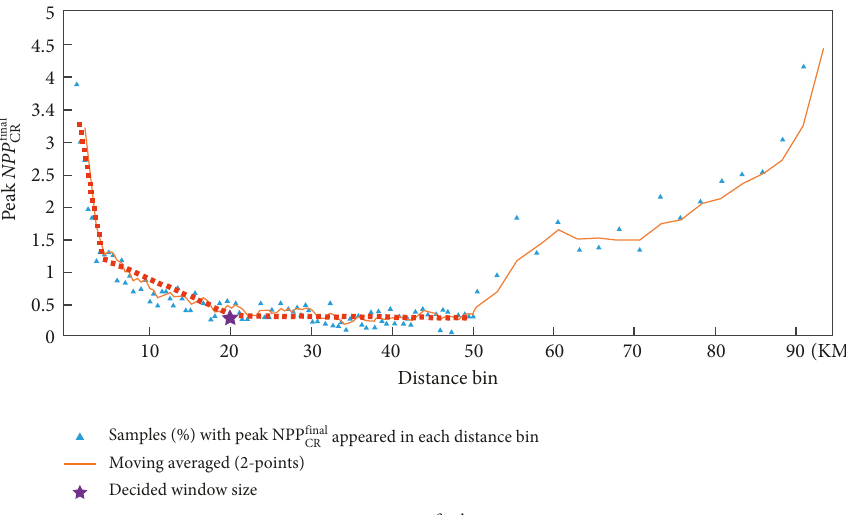
Figure 2: Samples with peak NPP CRfinal present in each distance